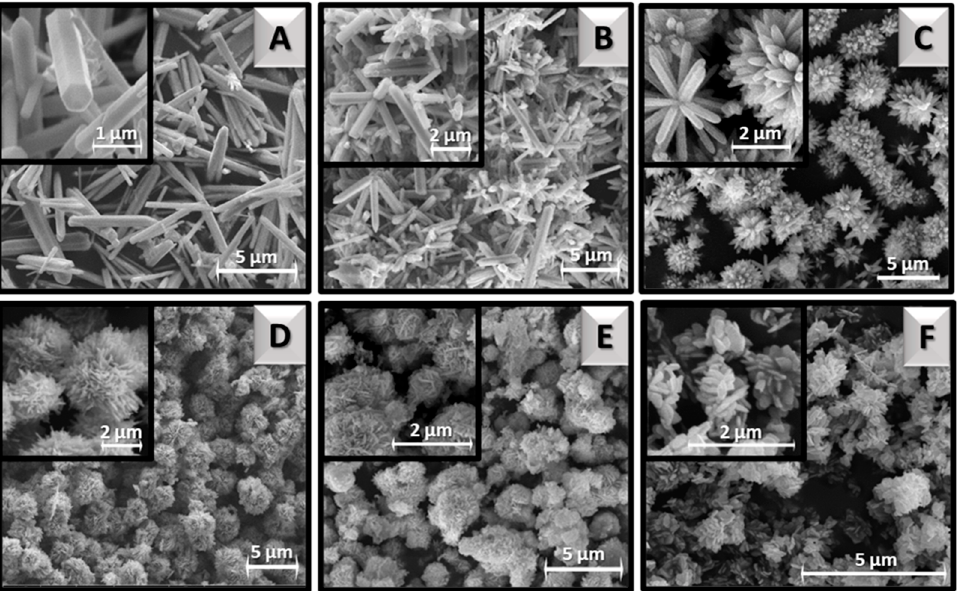
Figure 2. SEM images of ZnO particles synthesized hydrothermally at different temperatures: 100 ◦ C